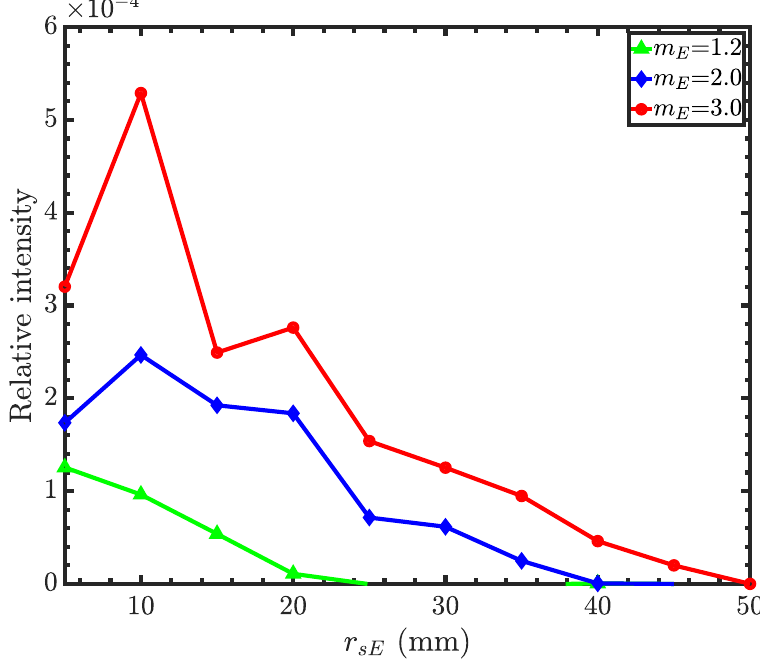
Figure 9. Relative intensities for the Wolter II microscope as a function of the ellipsoid mirror front-edge radius with different ellipsoid mirror coatings. The hyperboloid supermirror is m -1.2. The condenser and objective focal lengths are 750 mm. The non-monotonic decay of the intensity with the radius is a result of statistical fluctuations. Simulations were conducted using 10 6